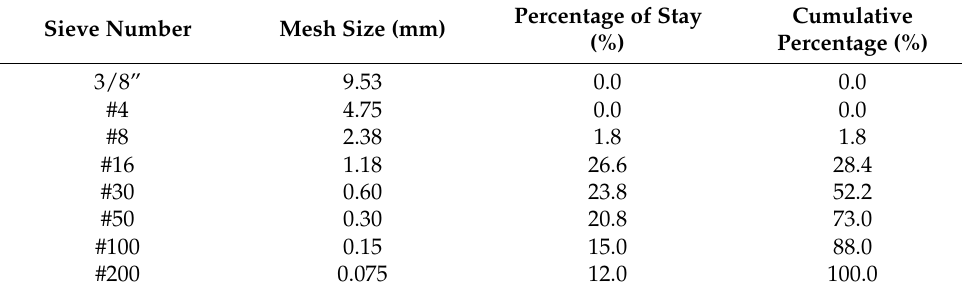
Table 8. Gradation distribution of recycled fine aggregate.